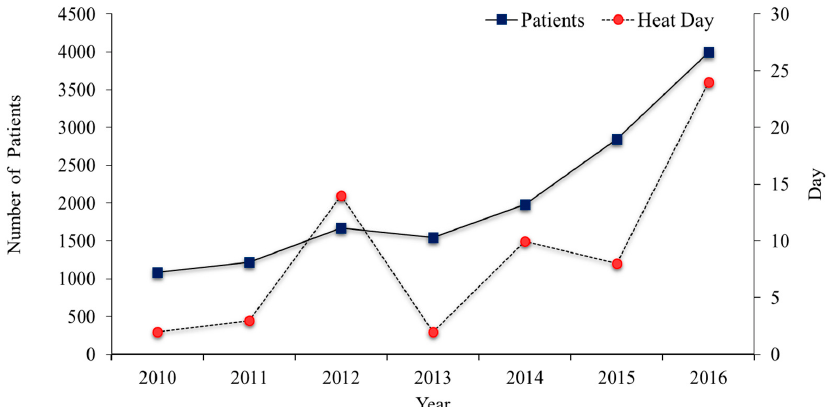
Figure 2. Number of patients with heat-related illness and number of heat days (those with daily maximum temperatures >33 °C) in Seoul (sources: National Health Insurance Service and Korea Meteorological Administration) .